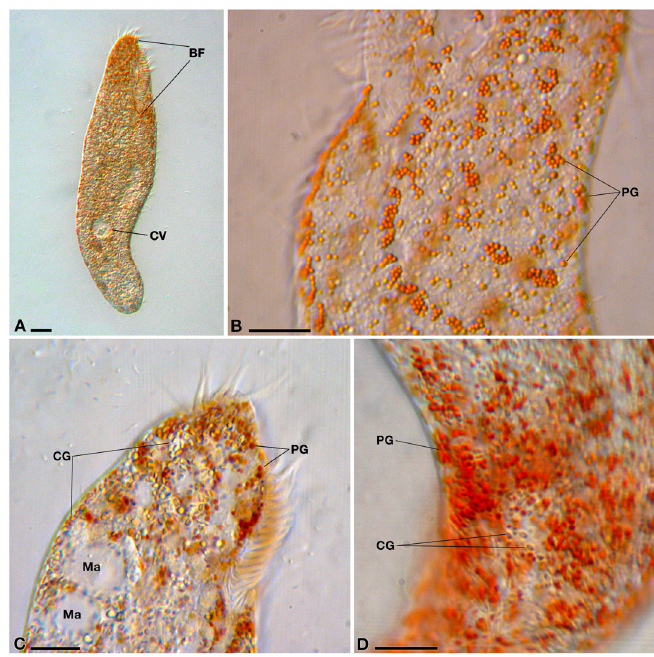
Figure 1. DIC images of Pseudokeronopsis cfr. erythrina PSqRJ01 in vivo. ( A ) A whole cell. The buccal field (BF) occupies between a third and a fourth of the cell length. A single contractile vacuole (CV) is present in the posterior half of the cell; ( B ) a lateral view just below the BF level, between the ventral (on the left) and the dorsal (on the right) cell side: pigment granules (PG) are generally associated with each component (i.e., ciliary unit) of the cell ciliature; ( C ) the anterior cell region. Both PG and ellipsoidal colourless granules (CG) are present. Two macronuclear beads (Ma) are also visible; ( D ) many PG are also distributed randomly throughout the cell cortical region. Bars stand for 10 µm.